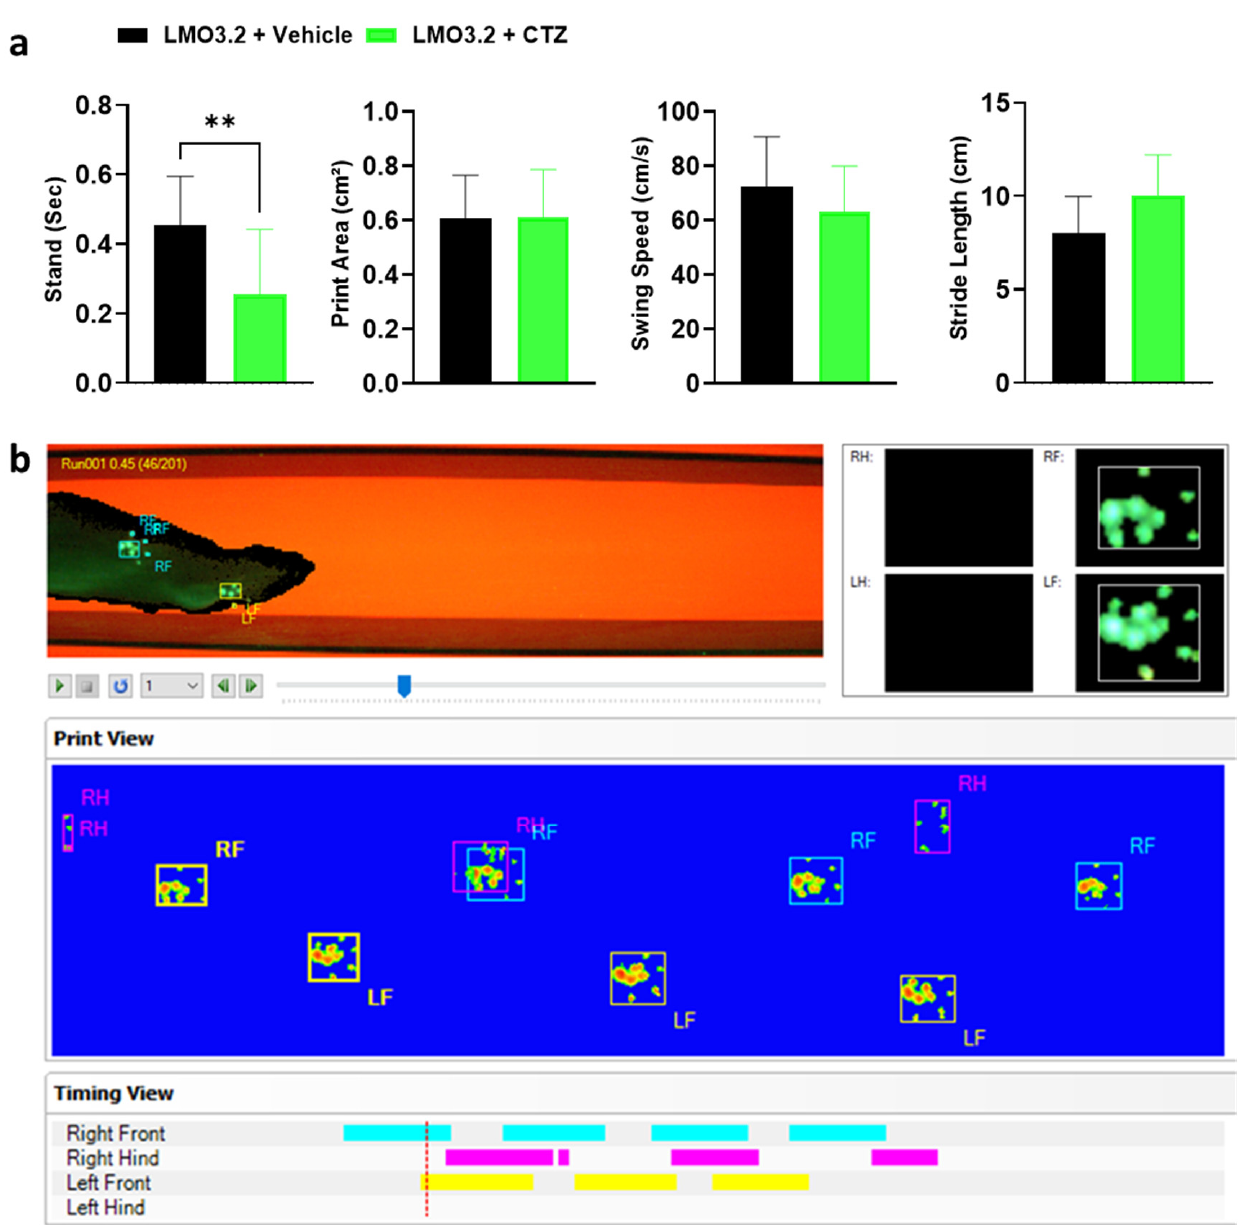
Figure 5. Gait parameters assessed and graphical print view of an injured rat on the CatWalk. ( a ) Stand, print area, swing speed, and stride length of vehicle- or CTZ-treated spinal cord injured rats. Stimulated rats showed a significant decrease in stand but no improvement in all other parameters analyzed. LMO3.2 + vehicle ( n = 7) and LMO3.2 + CTZ ( n = 8). LMO3.2 + CTZ vs. LMO3.2 + vehicle: ** p < 0.001. Error bars ± standard error of mean (SEM). ( b ) Pawprints were acquired using the CatWalk XT automated gait analysis system. Inappropriately labeled prints were manually corrected frame by frame for each run following auto-classification on the CatWalk XT ® software, version 10.6, Noldus Information Technology, Wageningen, The